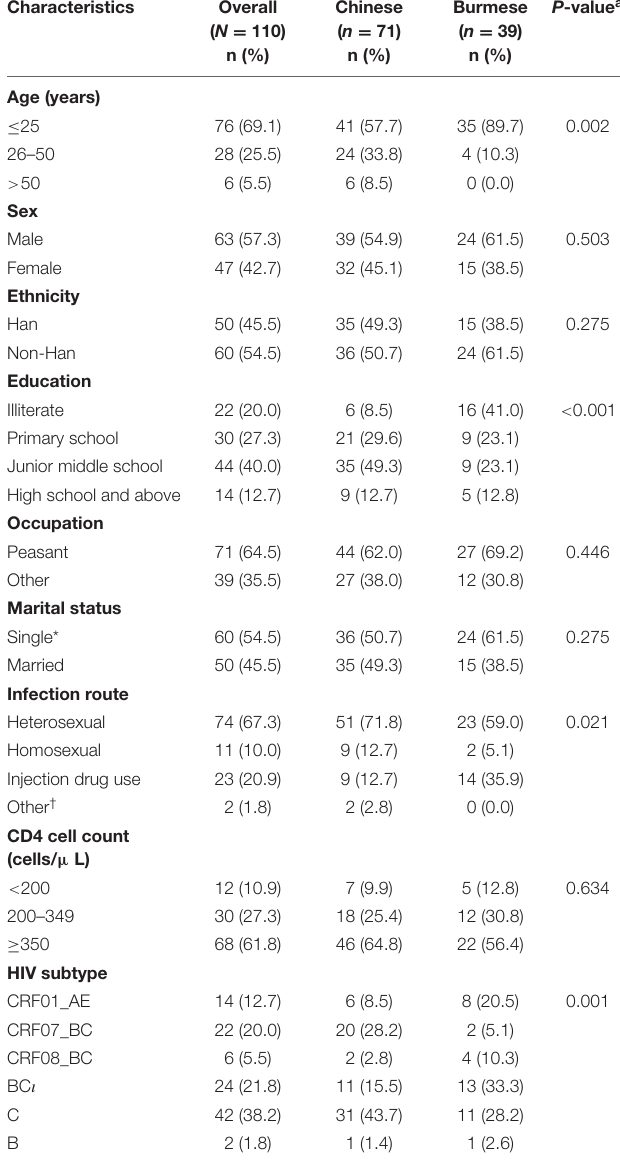
TABLE 2 | Demographic and clinical characteristics of individuals included in the MTCs stratified by nationality ( N = 110).